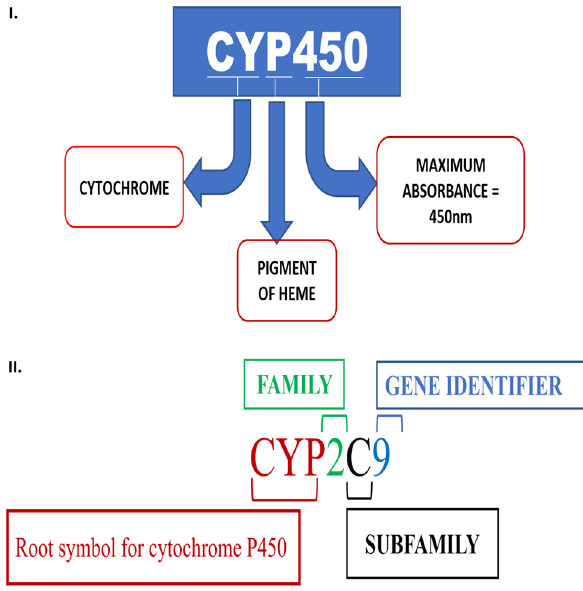
Fig. 3 I Diagrammatic rep- resentation of what CYP450 stands for. II Nomenclature for cytochrome family of